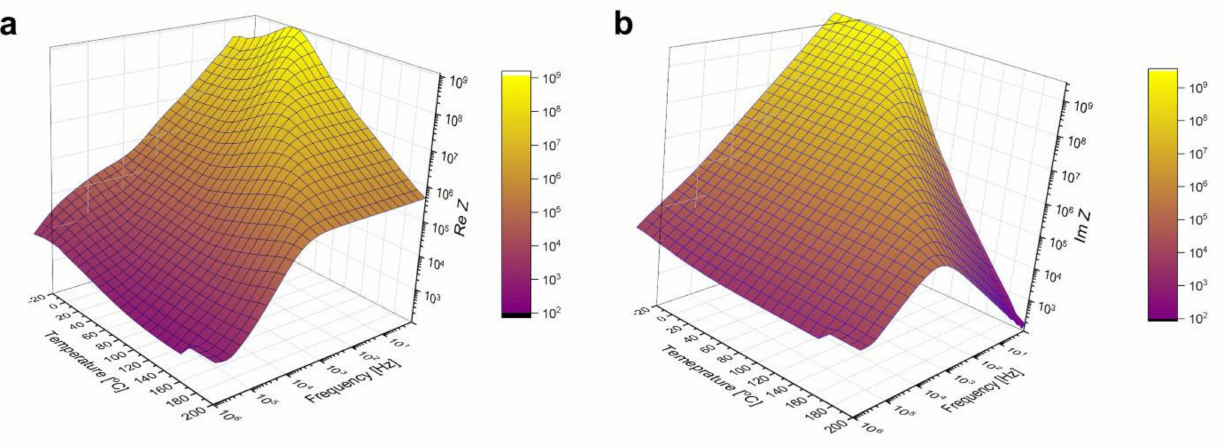
Figure 6. Real ( a ) and imaginary ( b ) part of the sample’s impedance as a function of temperature and frequency, measured by BDS.